Question: What type of chart is this?
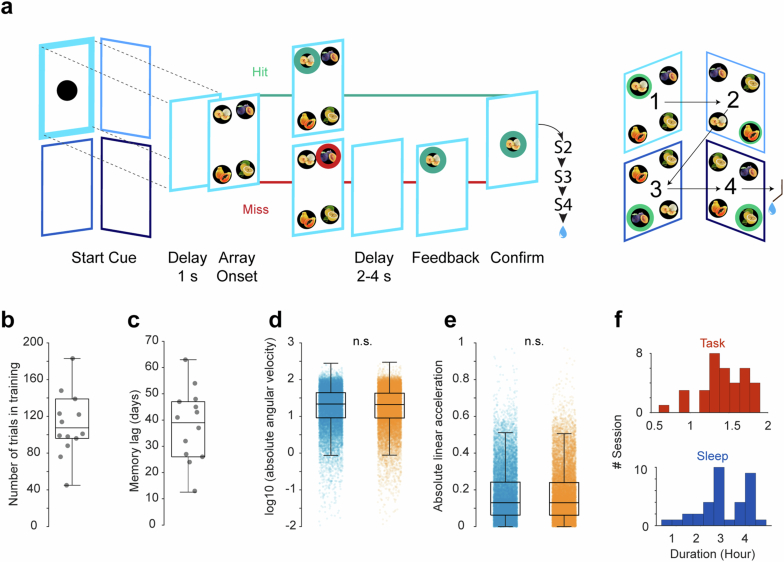
Answer: box